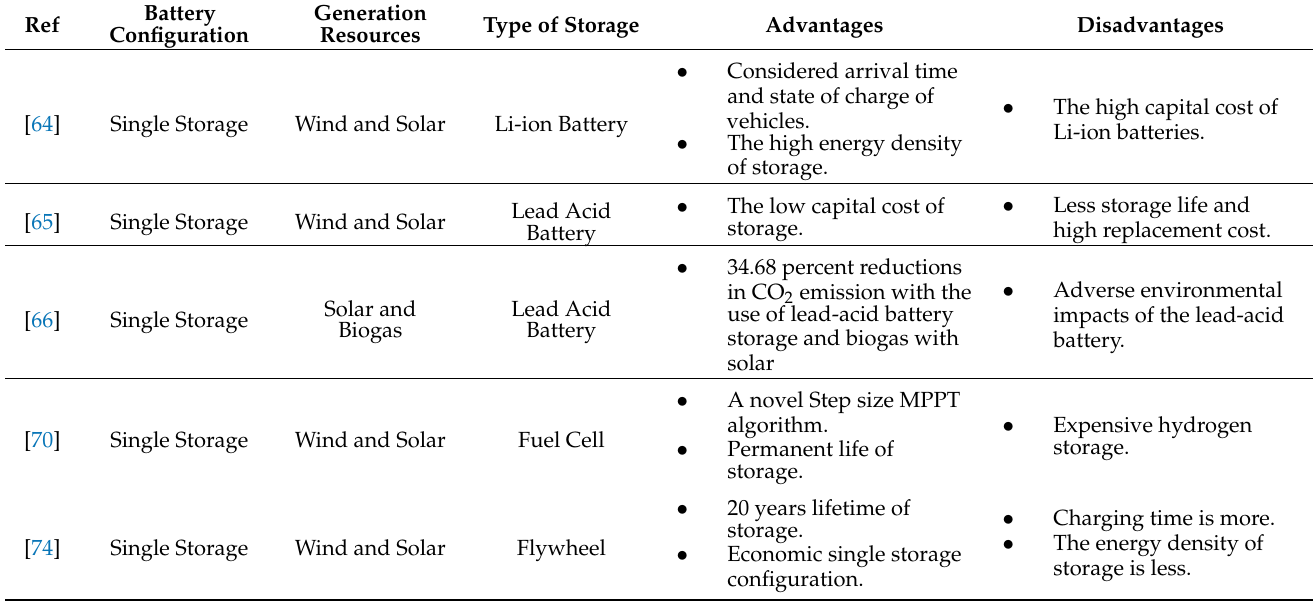
Table 4. Battery configurations in recent research